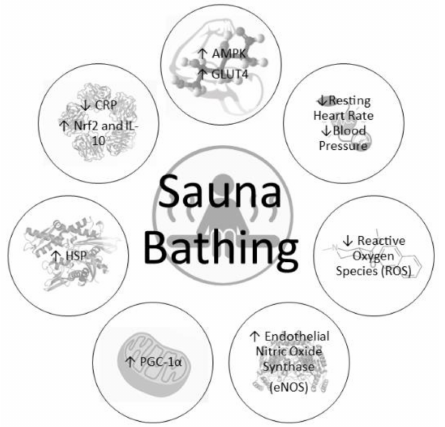
Figure 1. Physiological responses to chronic sauna